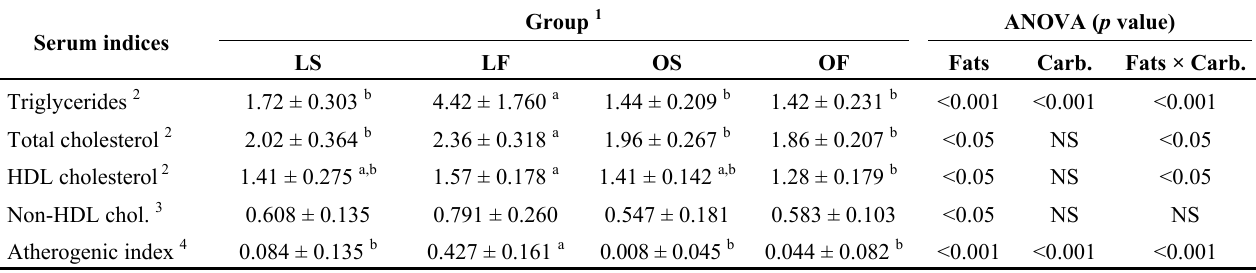
Table 4. Serum lipid profile and atherogenic index in rats fed high-fat diets differing according to the type of fats and